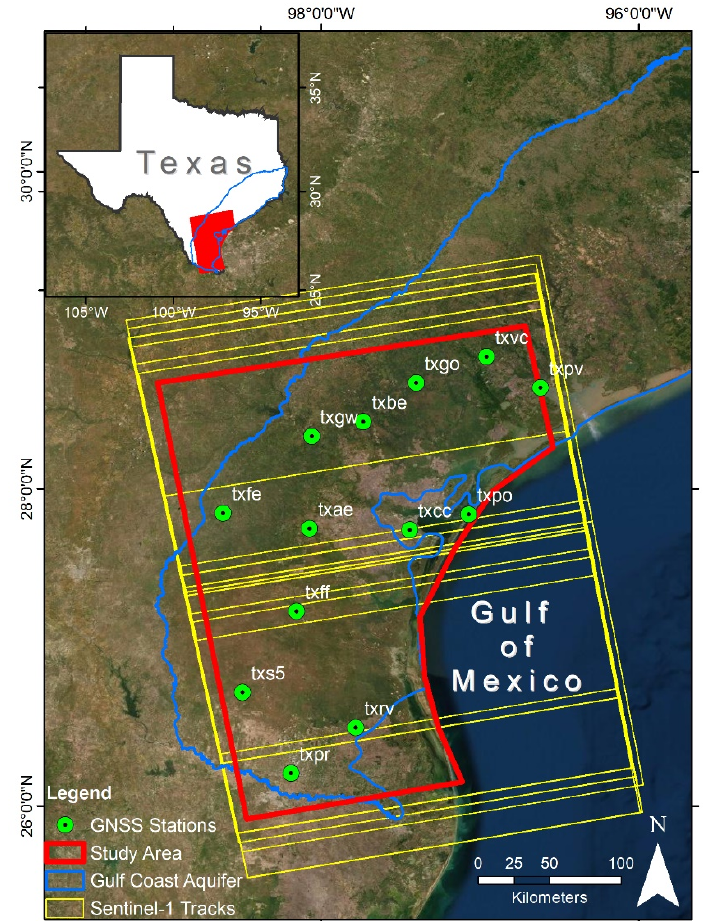
Figure 1. Environmental systems research institute (ESRI) world imagery showing the study area (red polygon) located in the Texas Coastal Bend, Sentinel-1 scene footprints (yellow polygons), the Gulf Coast aquifer (GCA; blue polygon), and locations of global navigation satellite systems (GNSS) stations used in this study (green circles). Inset shows the locations of the study area and the GCA in Texas.